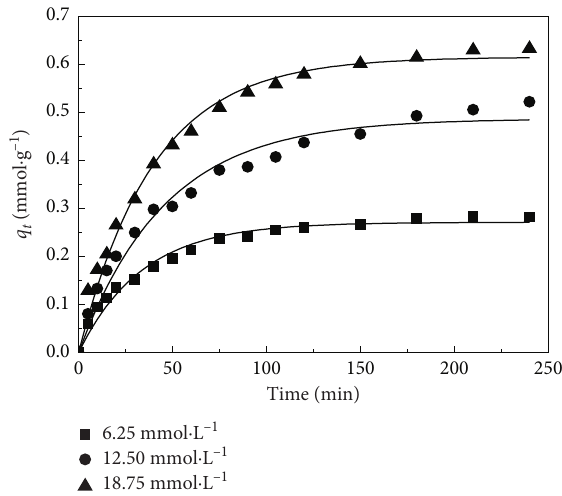
Figure 15: Nonlinear fitting of PSO model (adsorbent: 0.2g 2wt. : 20mL; c 0 : 6.25, 12.50, and 18.75 mmol · L − 1 DBT; adsorption %; v oil time: 4h; adsorption temperature: 313K).